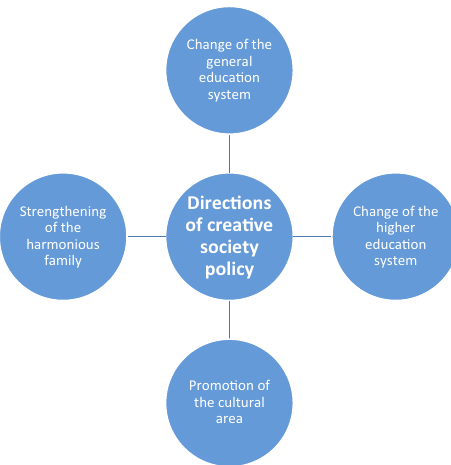
Figure 3. Directions of creative society policy (source: created by